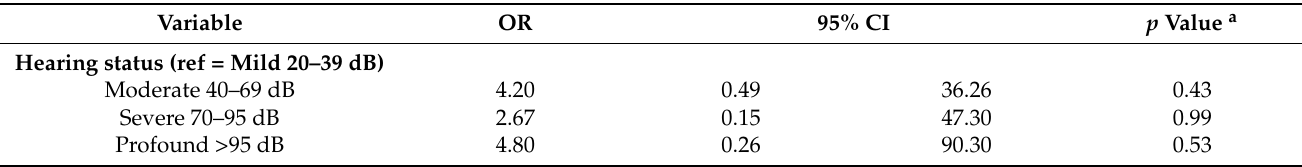
Table 4. Association of hearing loss and KCNQ4 c.546C>G variant in patients aged over 70.